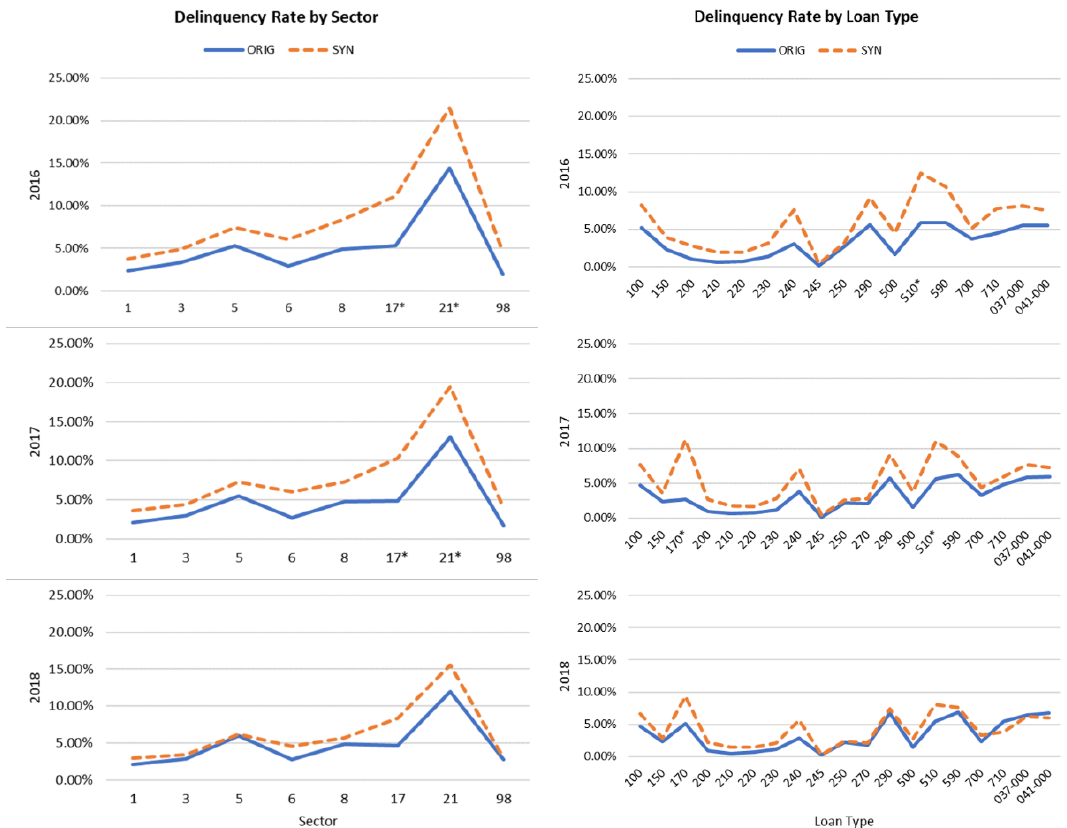
Figure 7. Delinquency rate by SECTOR ID and Loan Type at the end of each year from 2016~2018. (* indicates over the 5%-point difference between original and synthetic dataset).